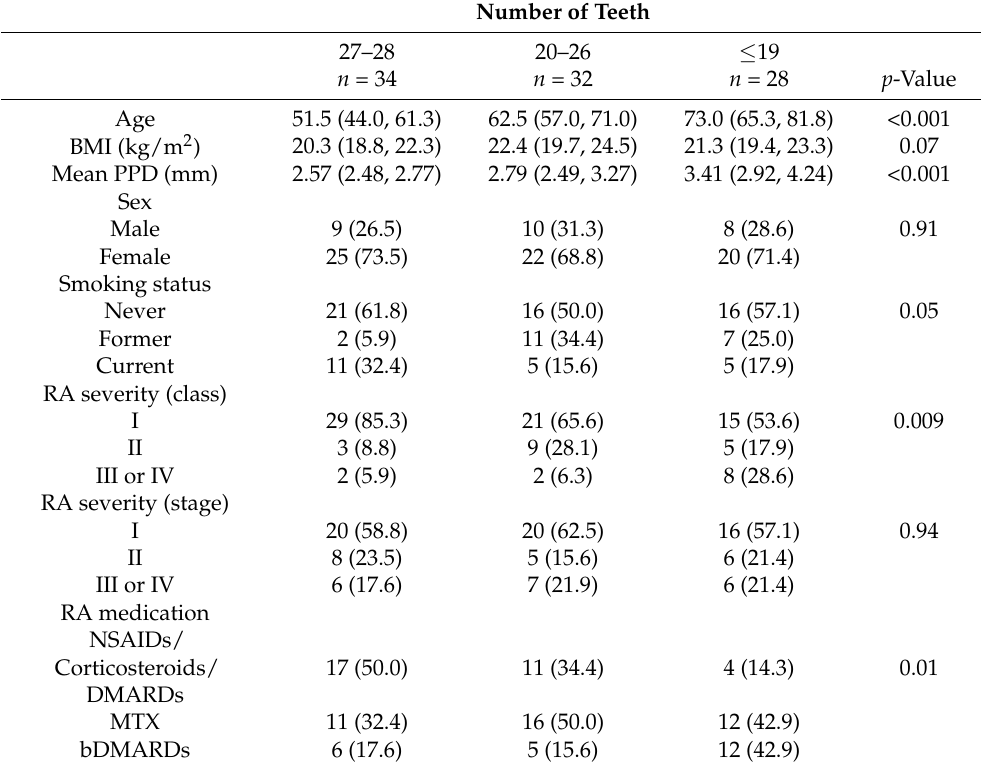
Table 2. Relationship between number of teeth and other variables in patients with RA.